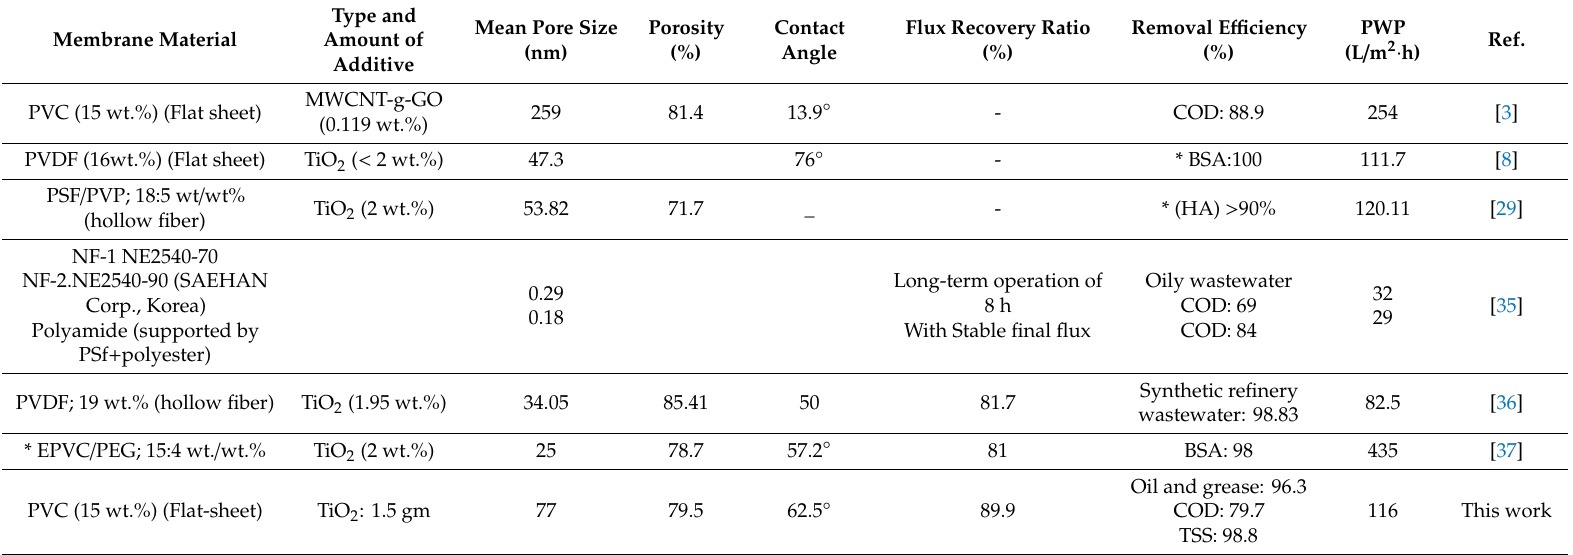
Table 7. Comparison between the performances of membranes prepared in this study with various membranes found in the literature in terms of total pure water flux, removal e ffi ciency, and flux recovery after long-term